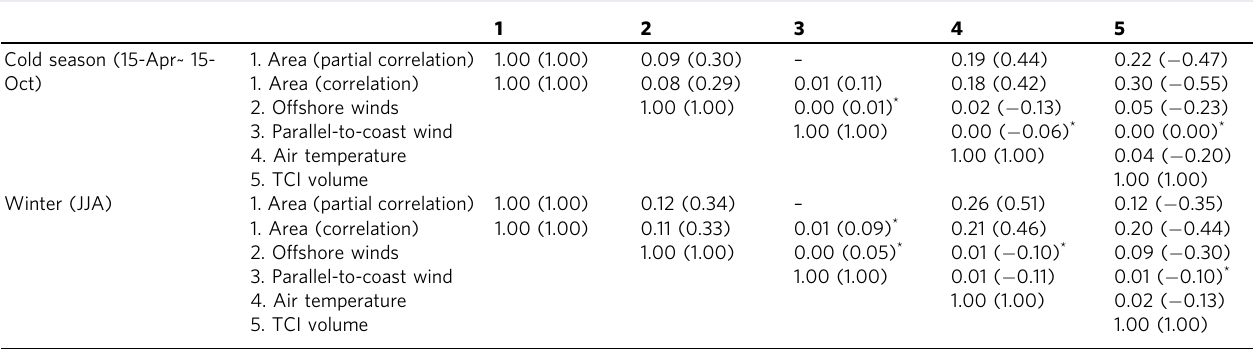
Table 1 Correlation coef fi cients among the TNBP area and its in fl ecting factors in the cold season (15-April~15-October) and winter (June-August).